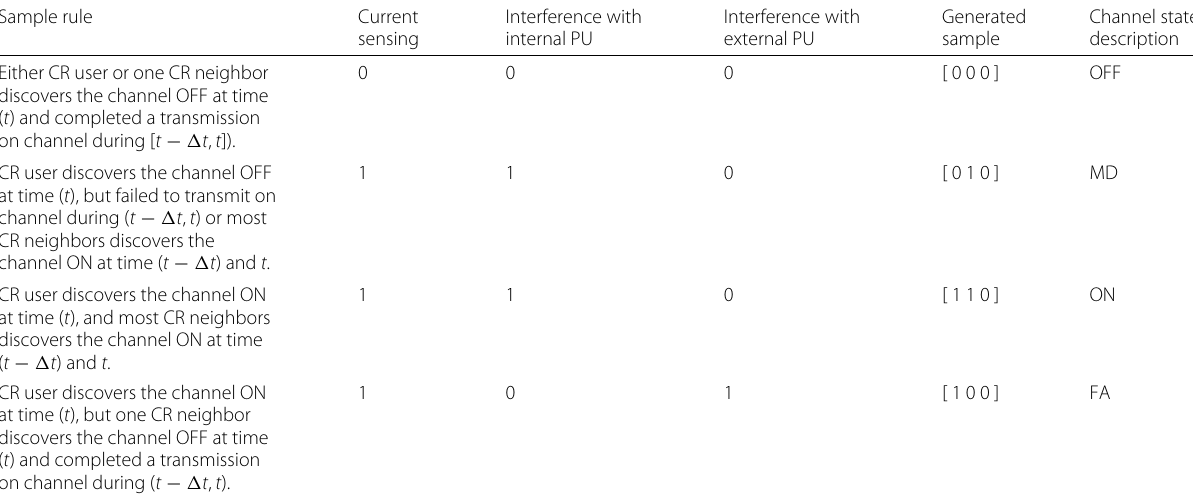
Table 1 Samples space for channel states Sample rule Current